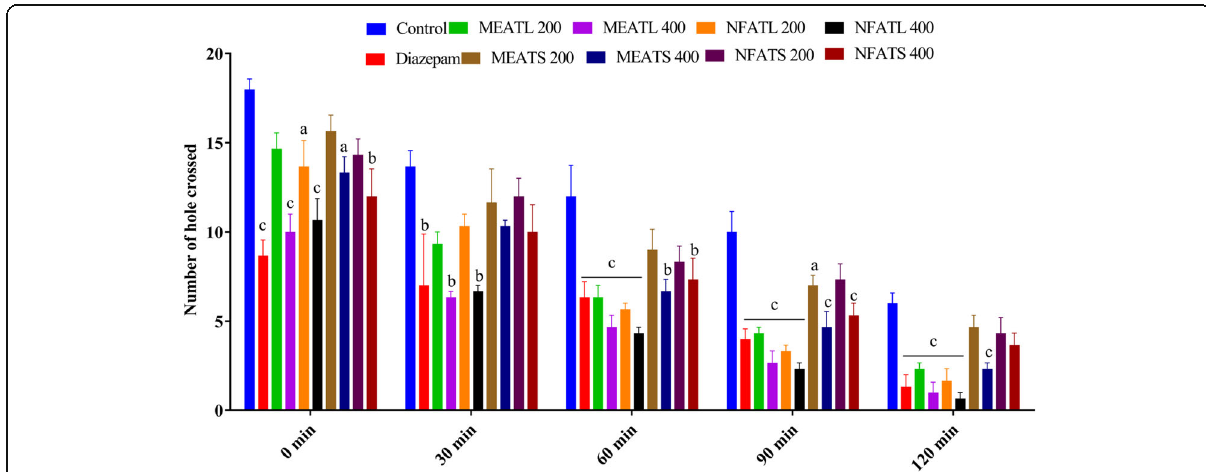
Fig. 2 Locomotor activity of different extracts of A. trilobata on hole-cross test in mice. The results were expressed in mean ± SEM, where a p < 0.05, b p < 0.01 and c p < 0.001 were considered as statistically significant. The statistical analysis followed by one-way analysis of variance (Dunnett ’ s test) compared to the negative control (1% Tween-80) using GraphPad Prism version 8.4. MEATL, methanol extract of A. trilobata leaves; NFATL, n-hexane fraction of A. trilobata leaves; MEATS , methanol extract of A. trilobata stem; NFATS, n-hexane fraction of A. trilobata